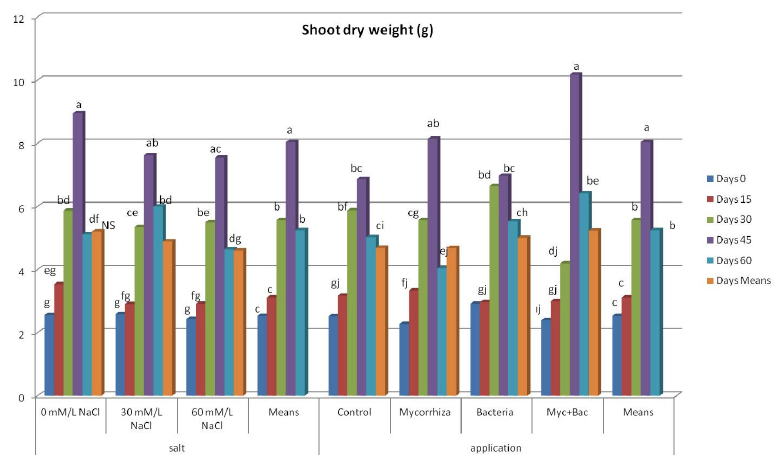
Fig. 2: Shoot dry weights of strawberry ‘San Andreas’ plants under salt (0, 30 and 60 mM/L NaCl) stress and applications (control, mycorrhiza, bacteria and myc+bac) for the periods of 0, 15, 30, 45 and 60